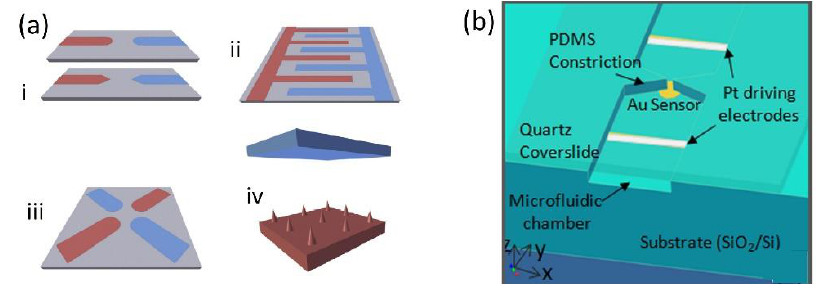
Figure 3. ( a ) Common electrode configuration for molecular eDEP (i) Electrode pair, (ii) IDE, (iii) quadrupole geometry, (iv) 3D geometry. Reproduced with permission [38] 2018, Elsevier. ( b ) Device geometry for the insulator constriction coupled to an electrically floating Au electrode sensor with immobilized DNA capture probe molecules. Reproduced with permission [70] 2012, AIP.